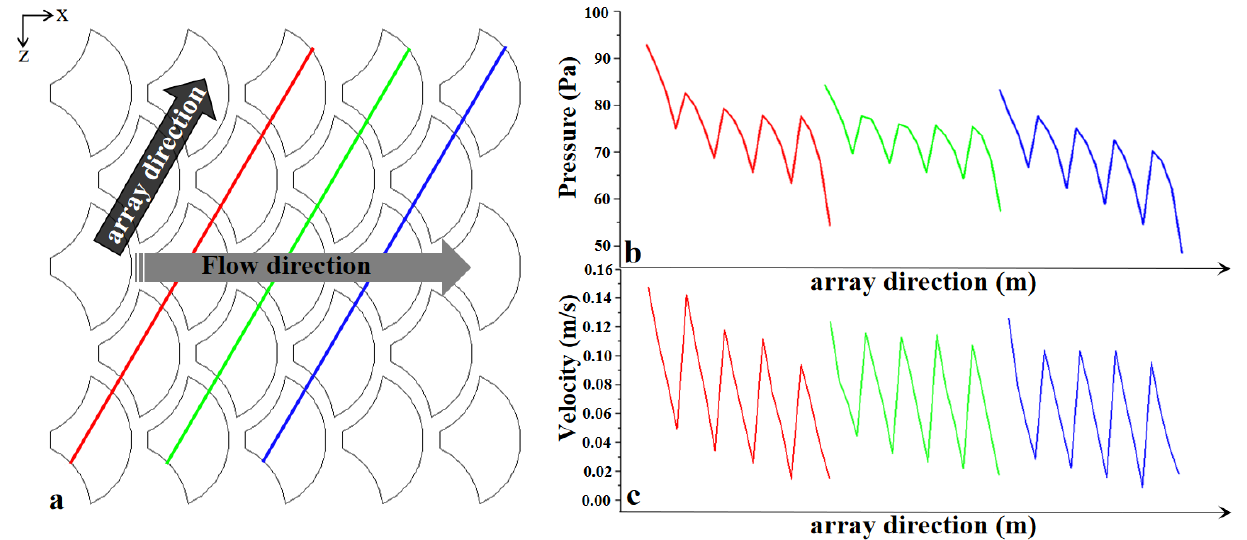
Figure 19. Distribution of pressure and velocity along array direction. ( a ) Value location and direction selection; ( b ) Distribution of pressure; ( c ) Distribution of velocity.